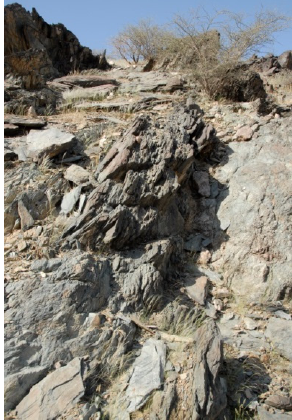
Figure 6. Highly fractured pelitic rocks consisting of schists and meta-shales along the Wadi Qidayd perimeter. Water 2016 , 8 , 1